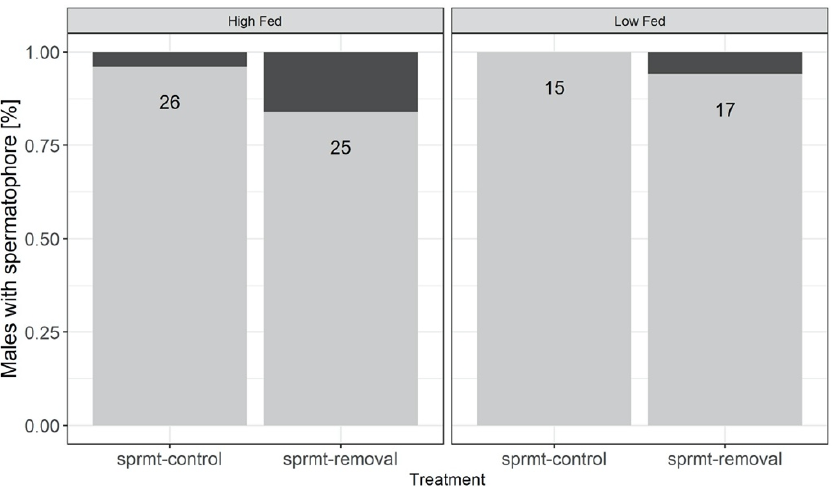
Figure 2. Proportion of males possessing a spermatophore at the end of the experimental treatment. Males were exposed to high and low feeding treatments (HF and LF), with and without experimental spermatophore removal (respectively, sprmt-removal and sprmt-control). Numbers inside bars are total sample sizes.